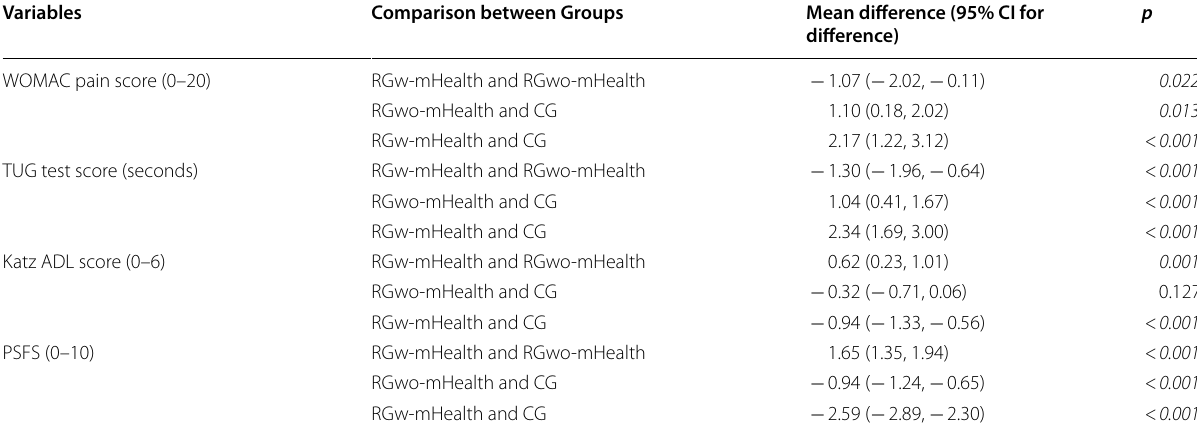
RGw-mHealth, rehabilitation group with mobile health; RGwo-mHealth, rehabilitation group without mobile health; CG, control group; WOMAC, Western Ontario and McMaster Universities Osteoarthritis Index; SD, standard deviation; TUG, timed up and go; ADL, activities of daily living; PSFS, patient specific functional scale;